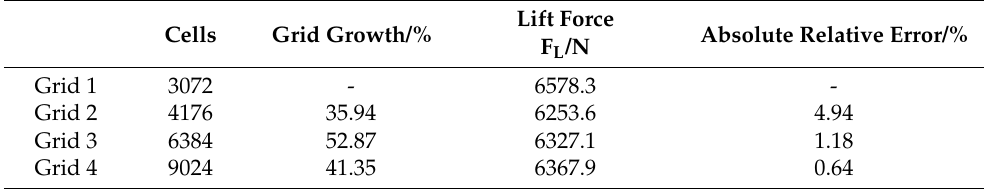
Table 2. Absolute relative error of lift force.